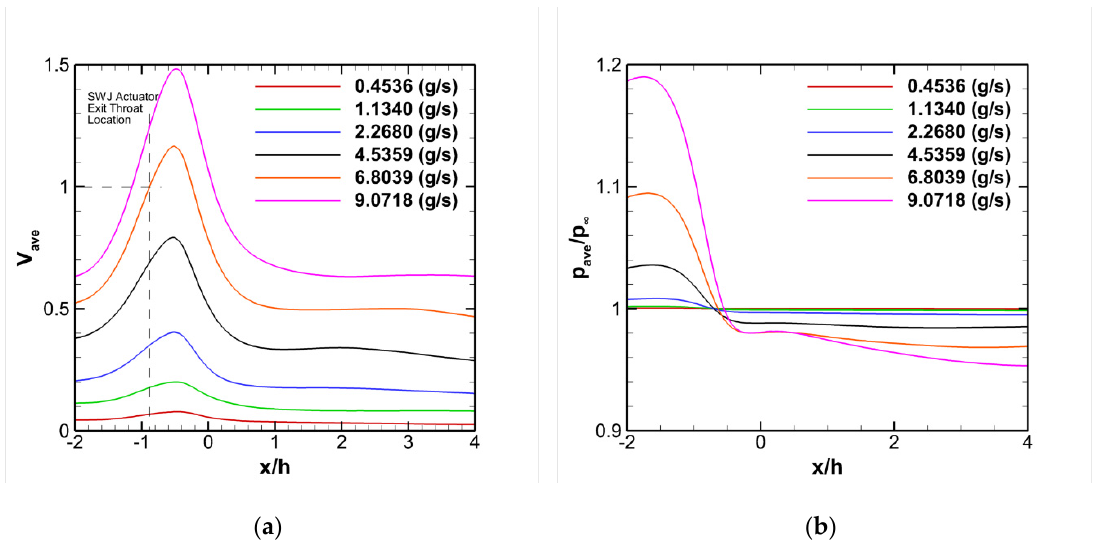
Figure 9. ( a ) Time-averaged velocity and ( b ) time-averaged static-to-reference pressure ratio along the centerline for different mass flow rates. For the mass flow rate of 6.8039 (g/s), the maximum value of averaged velocity magnitude at the throat is 148.03 m/s. The V ave,max occurs downstream of the throat and is equal to 172.66 m/s.